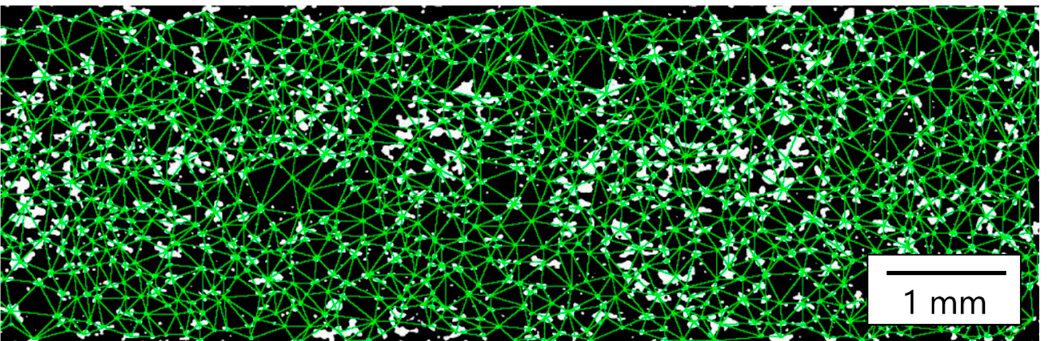
Figure 15. Measurement of the distance between the center of gravity points, to evaluate the dispersibility of the filler.